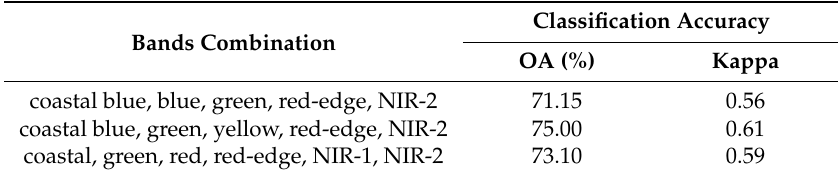
Table 6. Maximum Likelihood Classification accuracies for seagrass species mapping using different spectral combinations. OA is the Overall Accuracy.